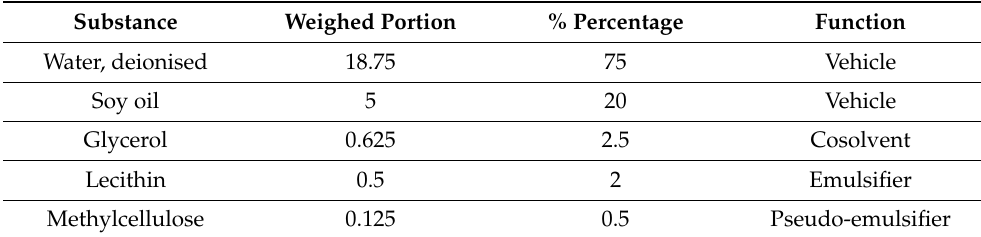
Table 2. Composition of the emulsion used to administer the